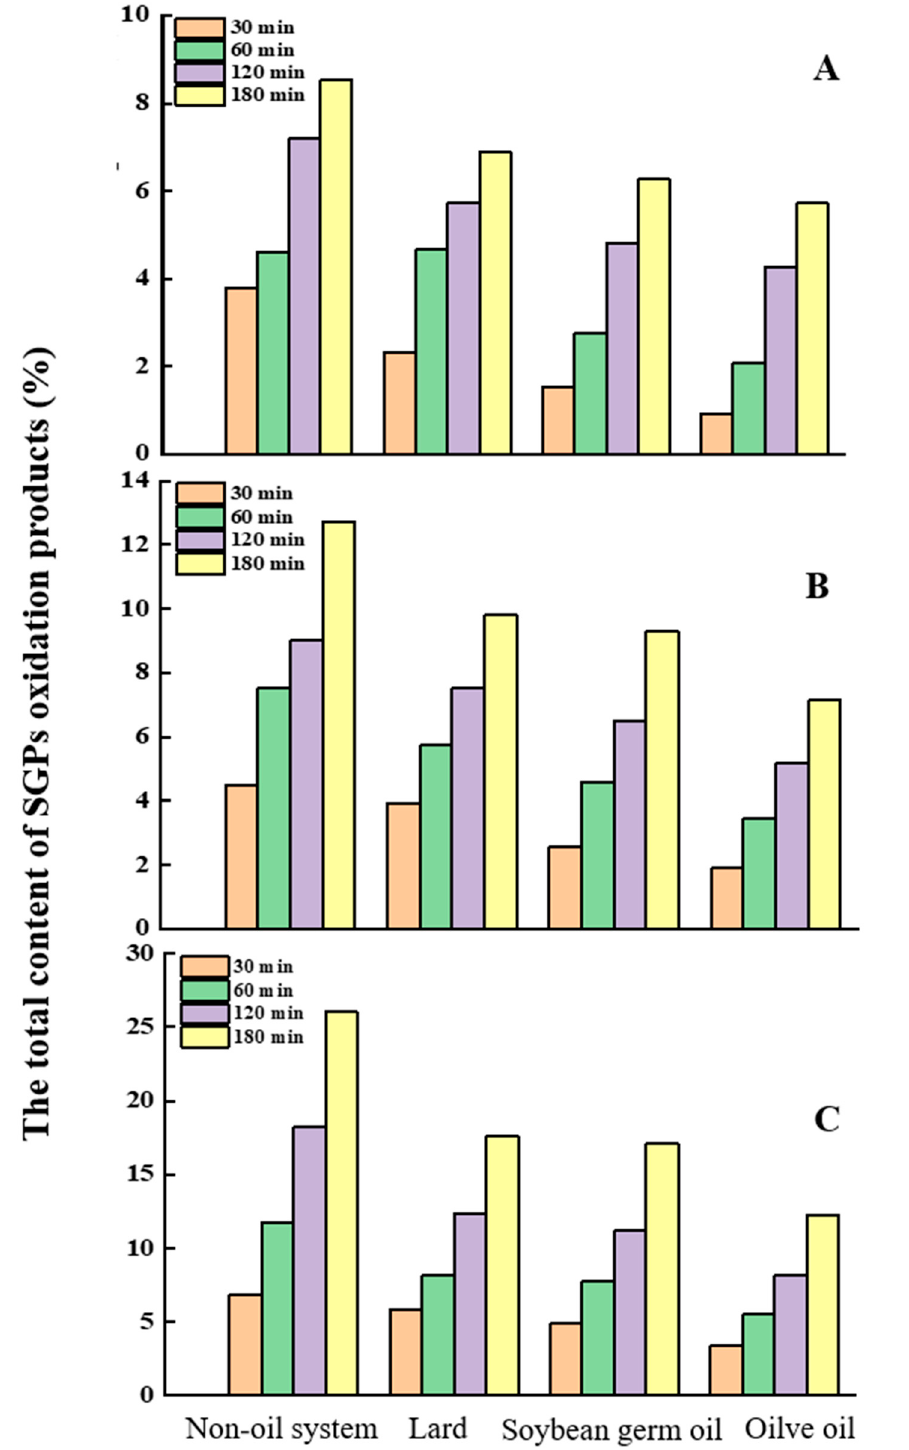
Figure 6. The content of total SGPs’ oxidation products in different systems (( A ), 120 °C; ( B ), 150 °C; ( C ), 180 °C).